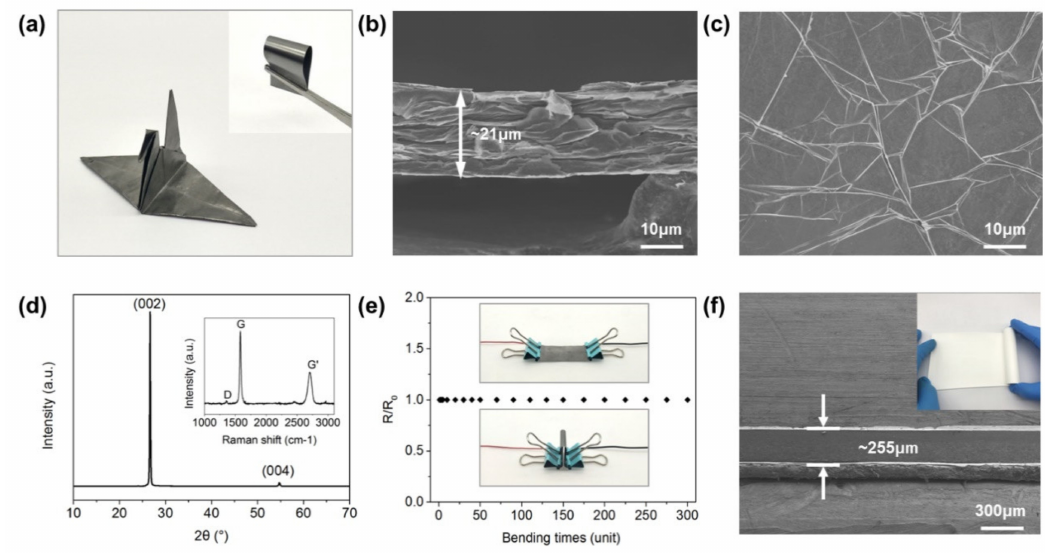
Figure 1. ( a ) Digital photographs of the graphene-assembled film (GAF) crane. ( b ) Cross-sectional and ( c ) top-view SEM images of GAFs. ( d ) XRD pattern and Raman spectrum (inset) of the GAF. ( e ) Mechanical stability test results of the GAF. ( f ) Cross-sectional SEM image and digital photograph (inset) of the